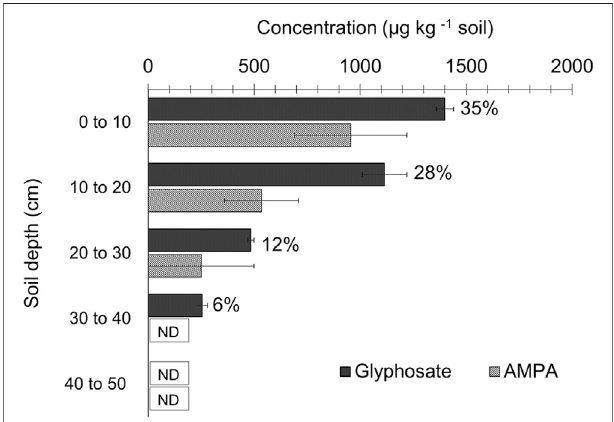
FIGURE 4 | Vertical movement of glyphosate and AMPA in the soil leaching columns (40 Days after treatment – DAT). Error bars, wherever visible, indicate 95% Con fi dence Interval. Values near the glyphosate bars in the graph indicate glyphosate accumulation as the percentage of herbicide initially applied. ND: not detected. Data showed up to 50 cm depth in the soil columns; Glyphosate or AMPA was not detected at or below this depth in the